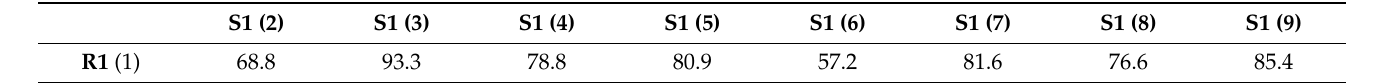
Table 2. Subject 1 intra-subject authentication test.